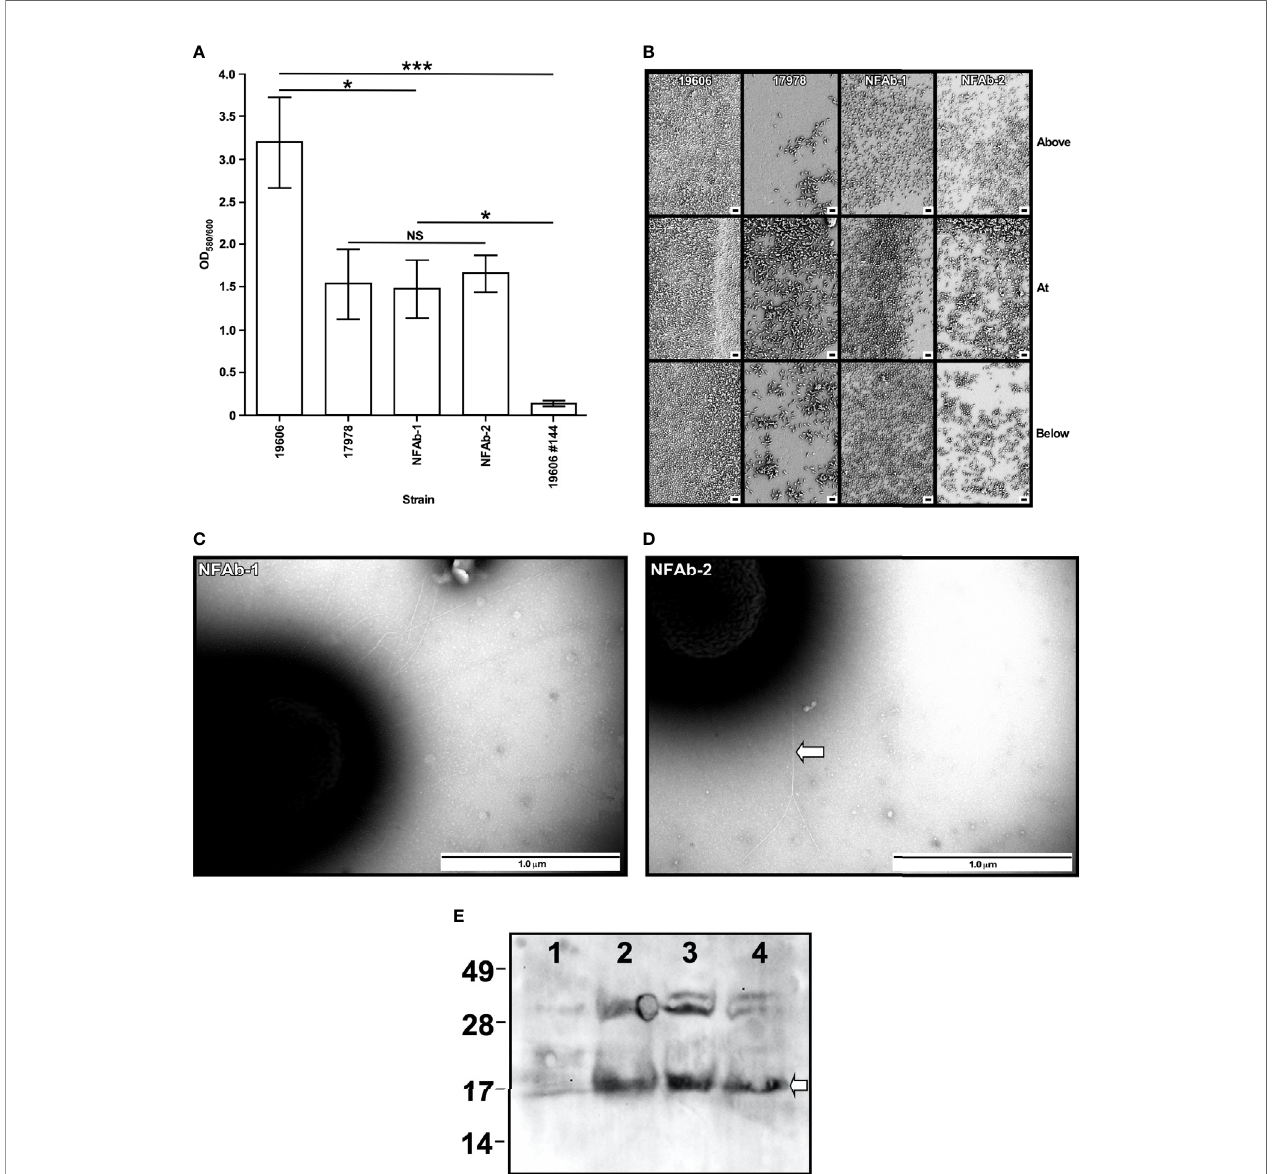
FIGURE 4 | Bio fi lm formation, pili detection and PilA production by A . baumannii strains. (A) The formation of bio fi lms on polystyrene tubes was detected after cells were incubated statically in MMB overnight at 37C. OD 600 was used to determine the total cell mass of each tested sample. OD 580 was used to determine the amount of bio fi lm formed on plastic tubes after staining with crystal violet and solubilization with acetone-ethanol. Triplicates of three independent biological samples were used to collect and analyze experimental data. Horizontal bars identify statistically different values ( P ≤ 0.05, *; P ≤ 0.001, ***, NS, not signi fi cant) and error bars represent the standard error of each data set. (B) SEM of bio fi lms formed on the surface of plastic coverslips semi-submerged in MMB and statically incubated overnight at 37°C. Samples were examined above, at and below the liquid-air interface. Images are representative of at least three micrographs collected at 5,000X magni fi cation for each biological sample. The black bars at the bottom right side of each panel represent a 2 µm size. (C, D) TEM of cells lifted form the surface of the Petri dishes after the agarose layer was removed from MMA plates. The horizontal white arrow in panel D identi fi es entangled pili forming bundles. Images are representative of at least three micrographs collected at a 60,000X magni fi cation for each biological sample. (E) Detection of PilA in ATCC 19606 T (lane 1), ATCC 17978 (lane 2), NFAb-1 (lane 3), and NFAb-2 (lane 4) total cell lysates. Numbers on the left indicate the position of molecular weight markers represented in kDa. The white arrow identi fi es the approximately 17-kDa PilA protein